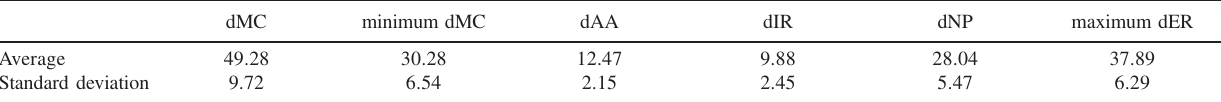
dMC = distance between the apex of coracoid process and the point of entry of the musculocutaneous nerve into the coracobrachial muscle minimum dMC = smallest distance between the apex of coracoid process and the musculocutaneous nerve dAA = smallest distance between the apex of coracoid process and the acromial artery dIR =distance between the lesser tubercle of the humerus and the apex of coracoid process as measured at maximum internal rotation of the humerus dNP = distance between the lesser tubercle of the humerus and the apex of coracoid process as measured at neutral position of the humerus dER = distance between the lesser tubercle of the humerus and the apex of coracoid process as measured at maximum external rotation of the humerus. Table 2 - Distances (mm) between the apex of coracoid process and the anatomical structures analyzed, stratified by sex, average (standard deviation)